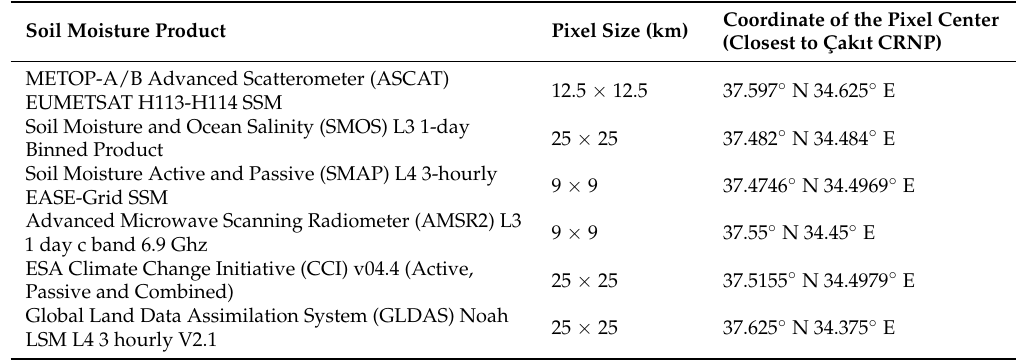
Table 1. Satellite soil moisture products that are compared with Çakıt Station COsmic Ray Neutron Probe (CRNP) soil moisture content